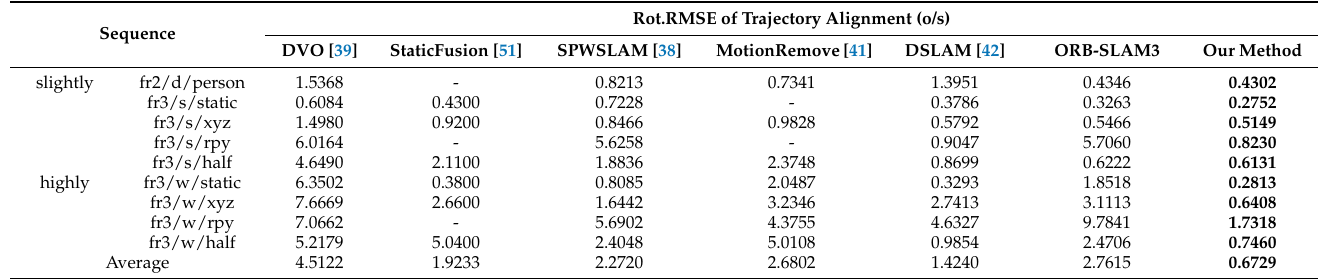
Table 1. Comparison of the Rot.RMSE of the RPE on the TUM benchmark.